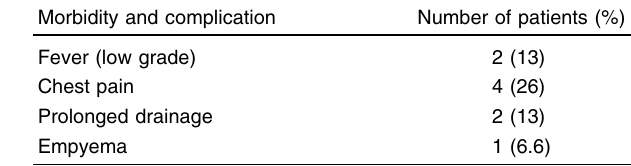
Table 3 Outcome of tetracycline poudrage pleurodesis in all studied patients Pleurodesis outcome